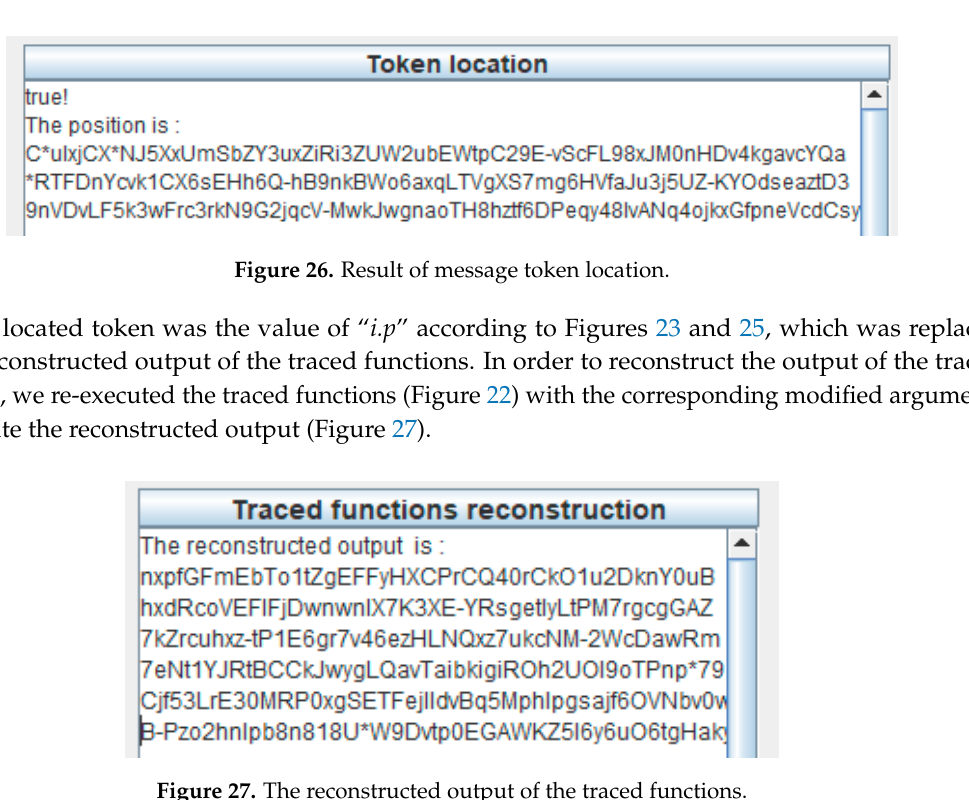
Figure 27. The reconstructed output of the traced functions.